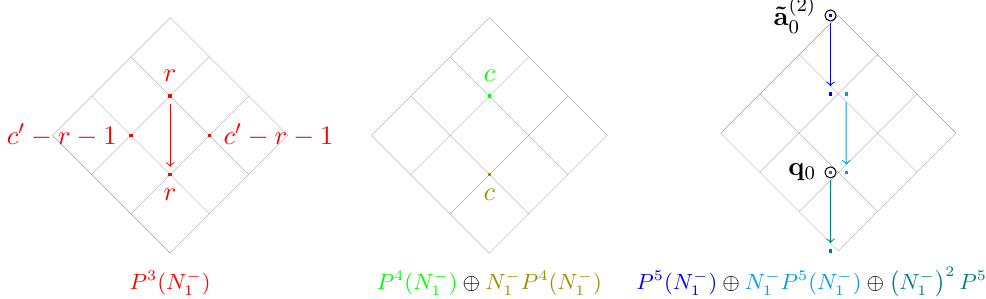
Figure 17 . Pictures showing the mixed Hodge structures induced on P 3 ( N (cid:0) ), P 4 ( N (cid:0) ) and 1 1 P 5 ( N (cid:0) ), together with their images under the action of N (cid:0) and ( N (cid:0) ) 2 . In these diamonds, the 1 1 1 coloured arrows label the action of N (cid:0) . The colourings are in agreement with (4.49) and (cid:12)gure 16. 2 The sum of these three Hodge-Deligne diamonds is the diamond of ( F ; W (2) ) of type IV d . As (2) before, q 0 and ~a (2) are denoted 0